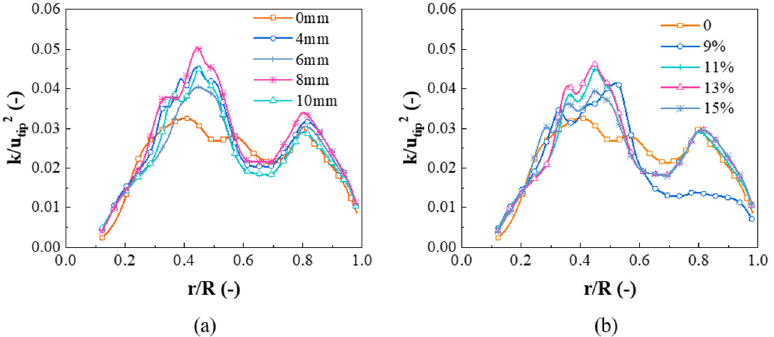
Figure 13. Influence of aperture parameters on local radial turbulence kinetic profiles. ( a ) Influence of aperture diameter, ( b ) influence of aperture ratio.